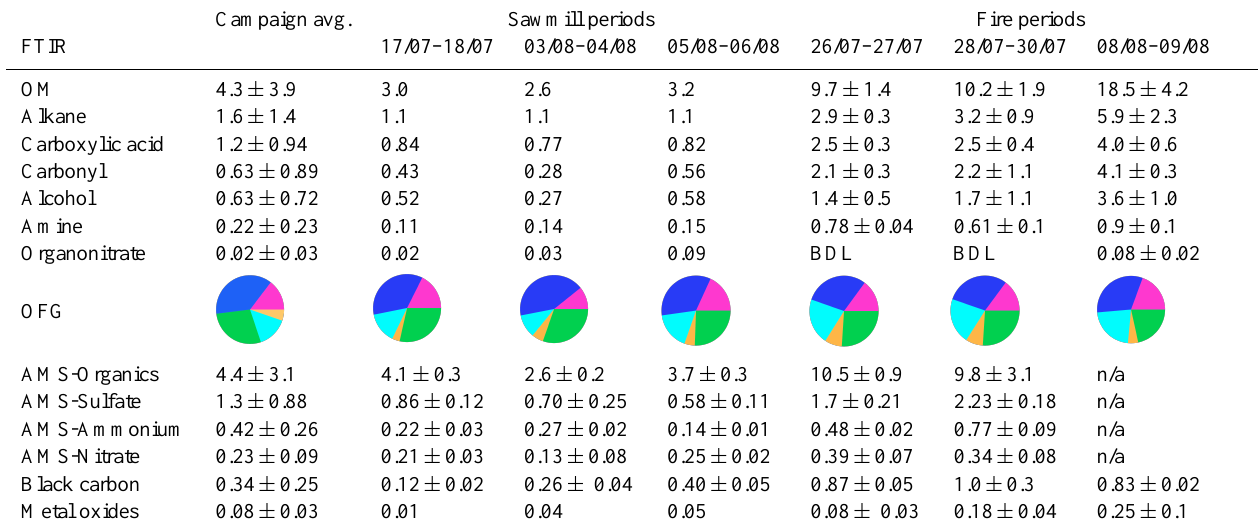
Table 2. Mean and standard deviation of measured OM, organic functional groups, sulfate, ammonia, nitrate, black carbon and mineral oxides for HUMPPA-COPEC: campaign average, sawmill and fire periods (concentrations in µgm − 3 ). Metal oxides were assumed to be SiO 2 , Al 2 O 3 , Fe 2 O 3 , and CaCO 3 (Usher et al., 2003); their concentrations were calculated from corresponding elemental concentrations quantified by XRF. Organic functional groups from FTIR, including alcohol (pink), alkane (blue), carboxylic acid (green), amine (orange), and carbonyl (teal).